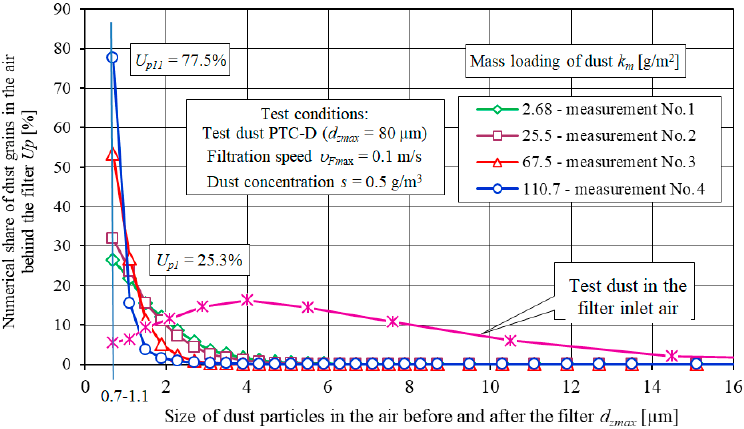
Figure 10. Share of dust particles in subsequent measuring intervals in the air upstream and downstream of the filter element A (cellulose).